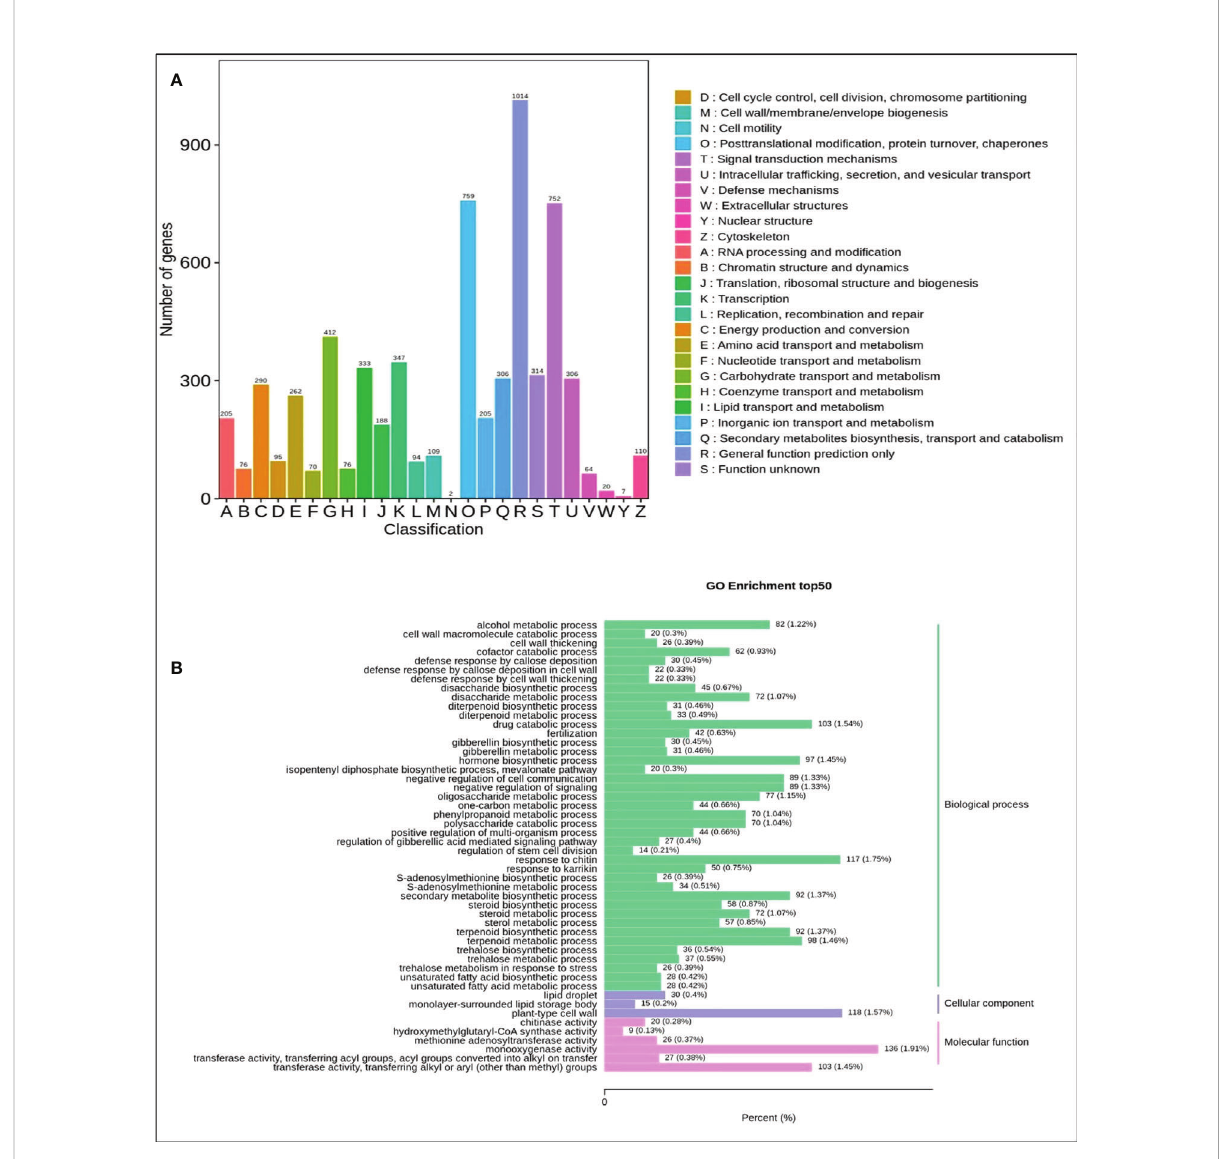
FIGURE 5 Classi fi cation of secondary entries of Qssg and Lc fruit difference genes. (A) Column chart of quantitative statistics of Qssg and Lc KOG functional classi fi cation. (B) Statistical map of the number of differential genes contained in the secondary go entries of Qssg and